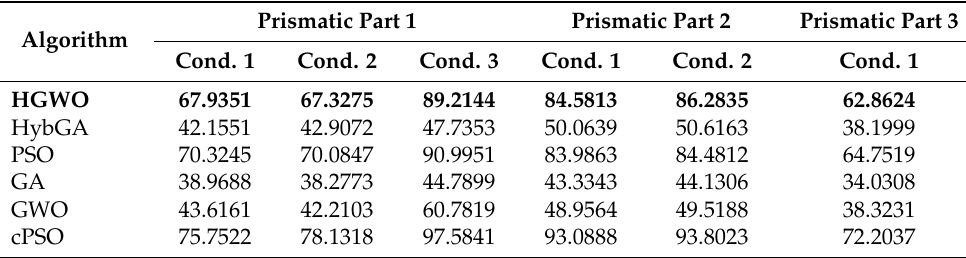
Table 12. Mean computational times (s) of five different algorithms for three experimental studies. Algorithm